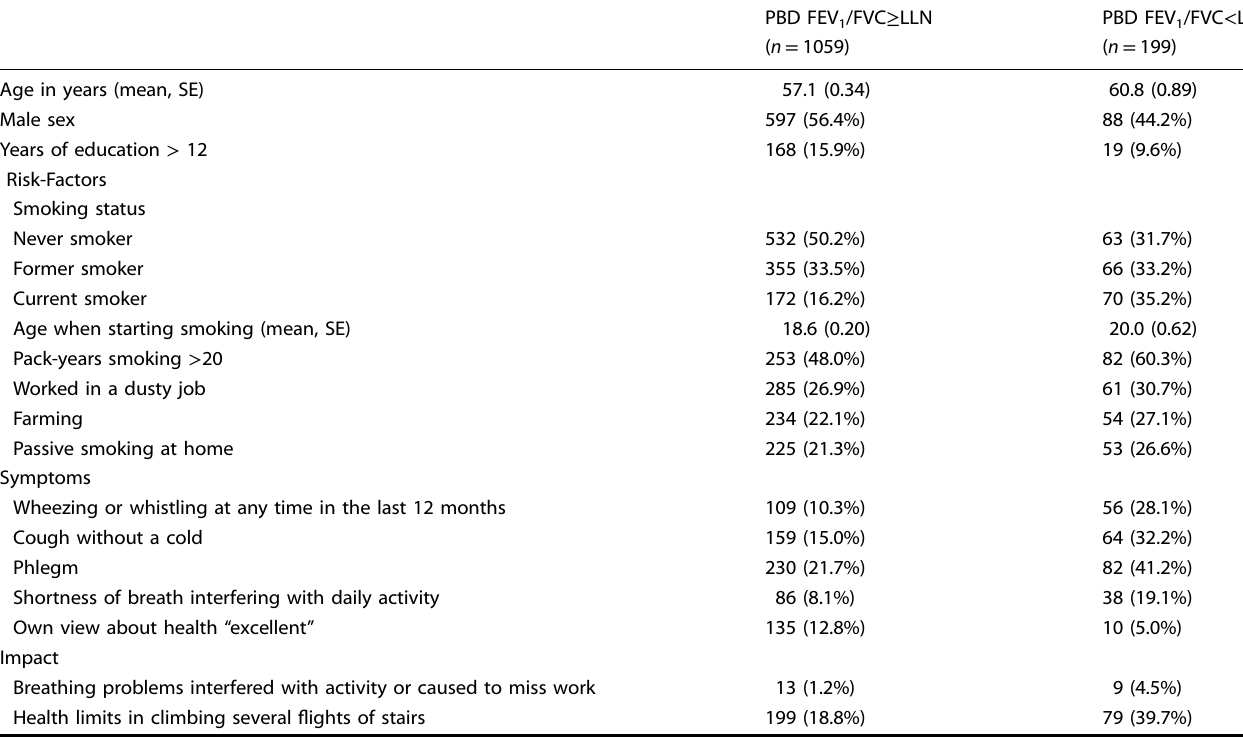
Table 4. Characteristics of subjects in the population-based BOLD-sample and the association with post-bronchodilator (PBD1) air fl ow limitation ( n =